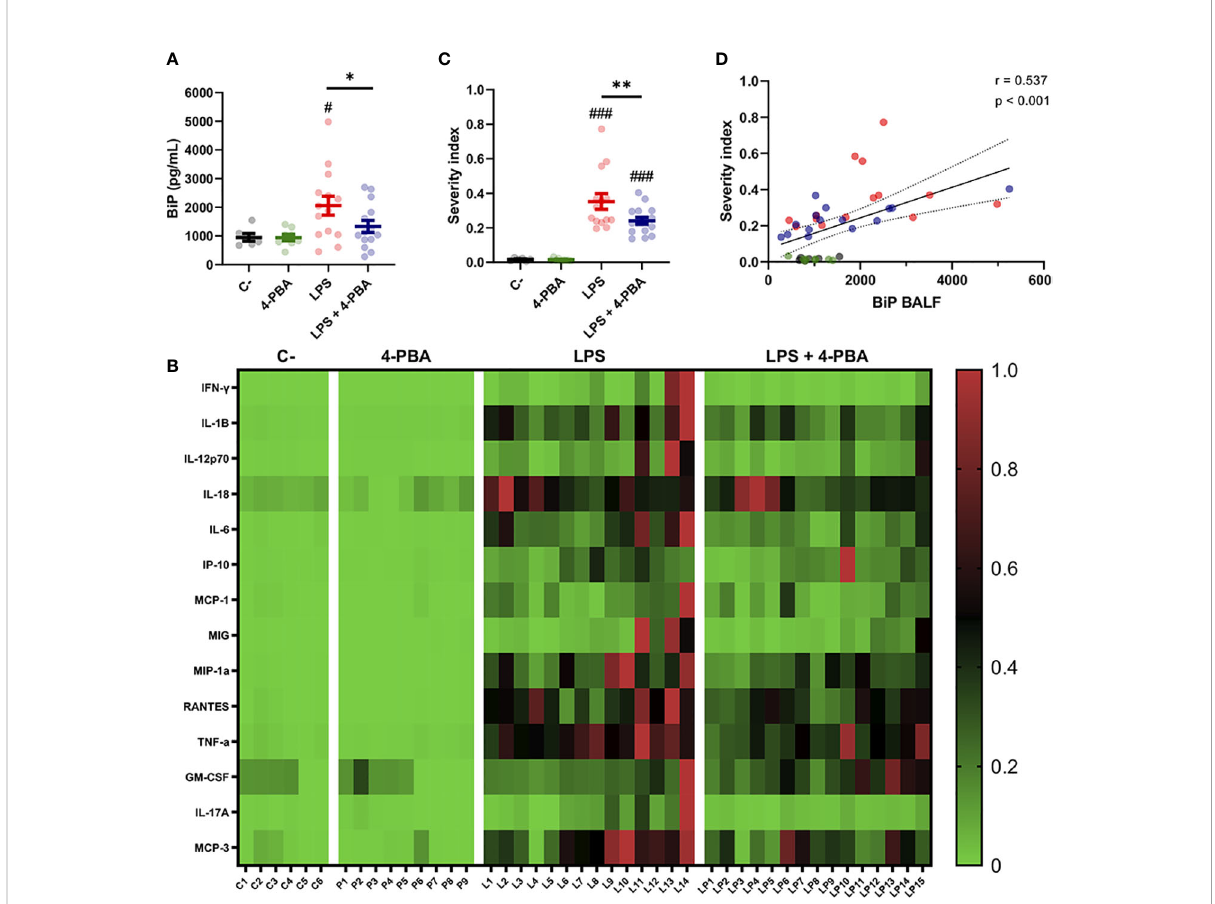
FIGURE 3 BiP levels correlate with ARDS severity. (A) BiP levels in BALF from control mice, 4-PBA treatment, challenged with LPS with and without 4-PBA treatment. Colored lines and whiskers denote mean ± SEM for every data set. Hash marks indicate signi fi cant difference versus non-LPS challenge conditions ( # P < 0.05) and a straight line between LPS and LPS + 4-PBA (* P < 0.05, ** P < 0.01) by Two-way ANOVA followed by Tukey ’ s post-hoc test. (B) Heatmap showing levels for all measured cytokines for every single mouse (In the X axis: C = C -; P = 4-PBA ; L = LPS and LP = LPS + 4- PBA with numbers indicating replicate number). Normalized cytokine values are depicted on a low-to-high scale (green- black-red). (C) Severity Index calculated as an average of normalized values for all cytokine by every single animal. Values near to 1 indicate more severe outcome whereas values tendent to zero a milder response. Colored lines and whiskers denote mean ± SEM for every data set. Hash marks indicate signi fi cant difference versus non-LPS challenge conditions ( ### P < 0.001) and a straight line between LPS and LPS + 4-PBA by Two-way ANOVA followed by Tukey ’ s post-hoc test. (D) Scatter plot showing a positive correlation between BiP levels in mice BALF and the calculated Severity Index tested by Pearson ’ s correlation coef fi